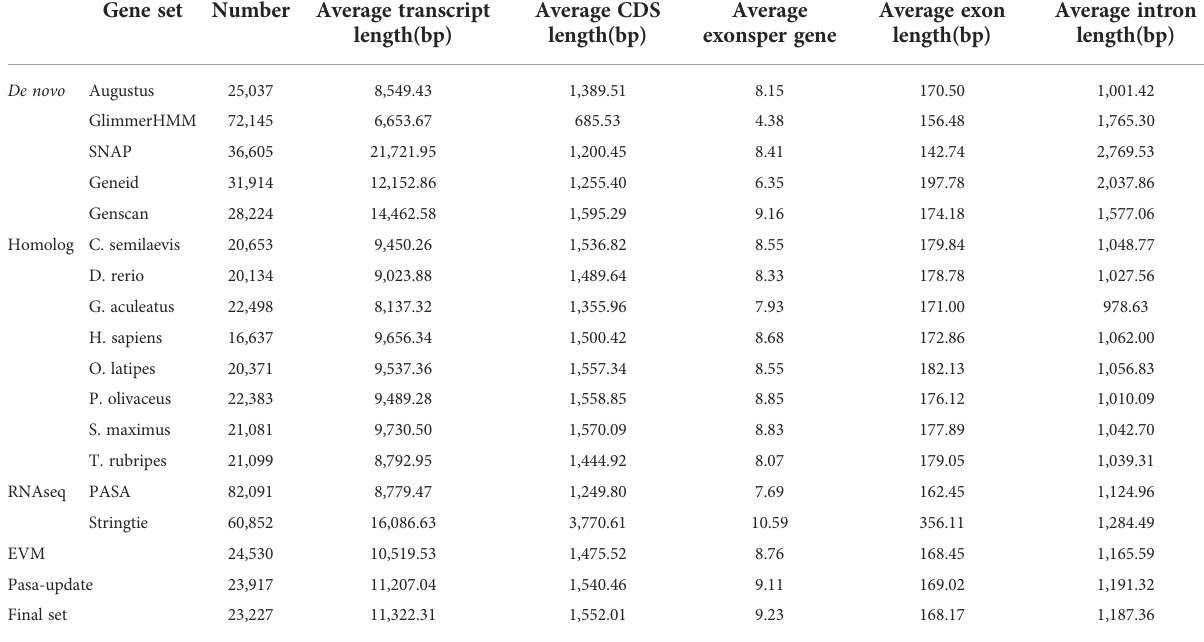
TABLE 4 Summary statistics of the identi fi ed protein-coding